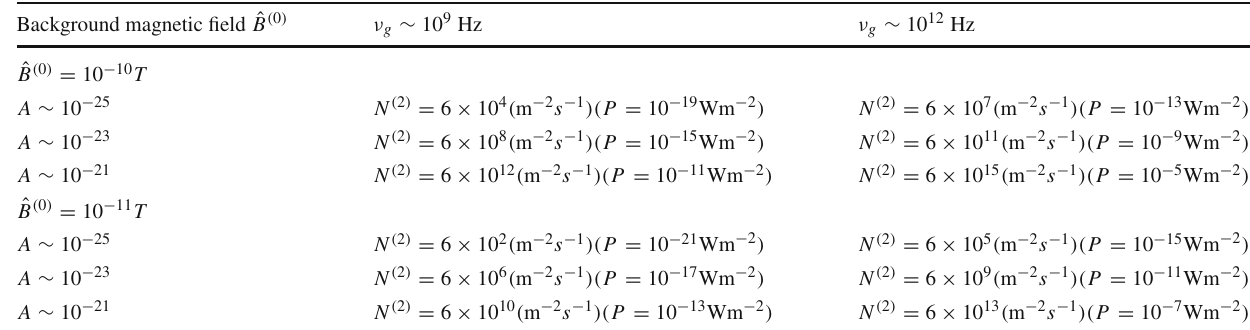
signal power flux densities (Wm − 2 ) at the Earth. Here, “ A ” represents possible GW amplitude around the Earth [could be one of A ⊕ , A ⊗ , A x , A y , A b , A l in Eqs. (38) to